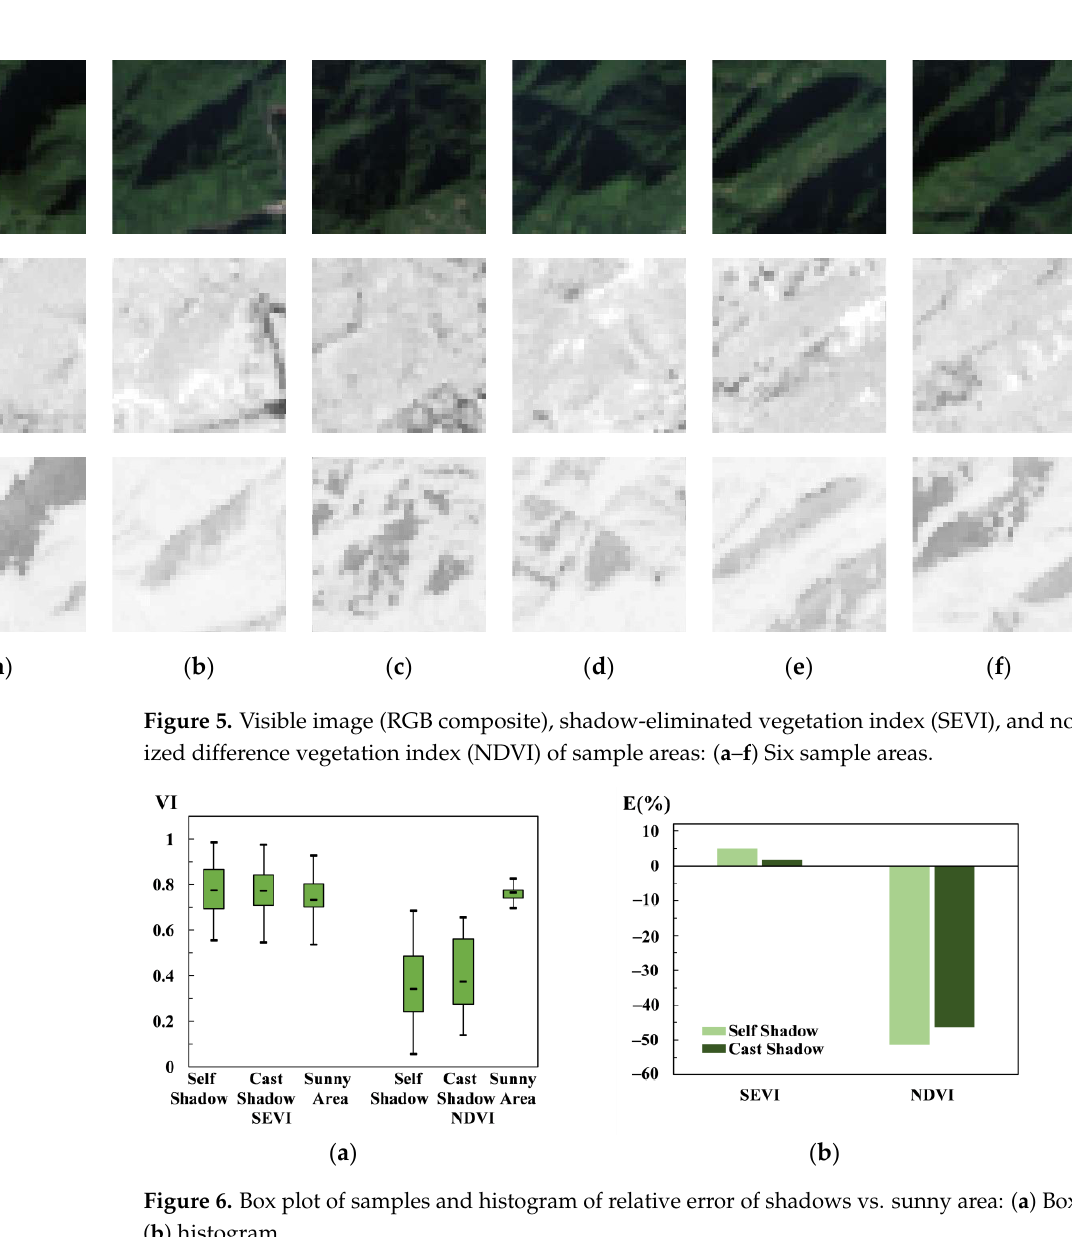
Figure 4. Mosaicked SEVI and scatter plots: ( a ) SEVI and points in intersected area (yellow points); ( b ) graded SEVI; ( c ) scatter plots of SEVI points in intersected area.